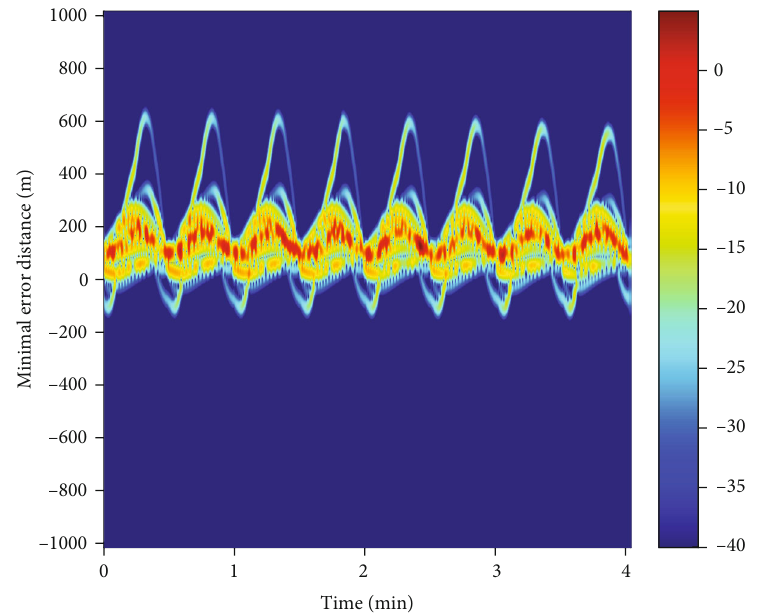
Figure 9: Research on track smoothness based on the Kalman fi